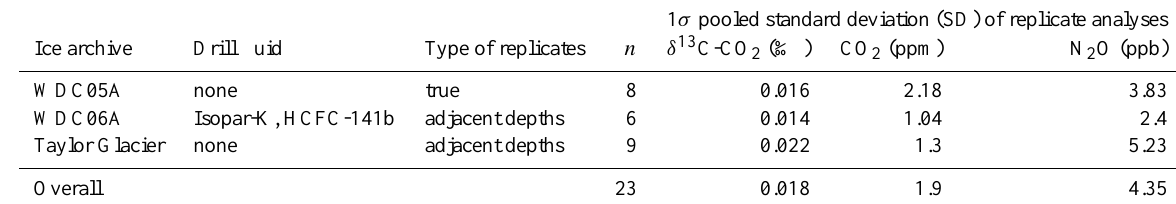
1 σ pooled standard deviation (SD) of replicate analyses